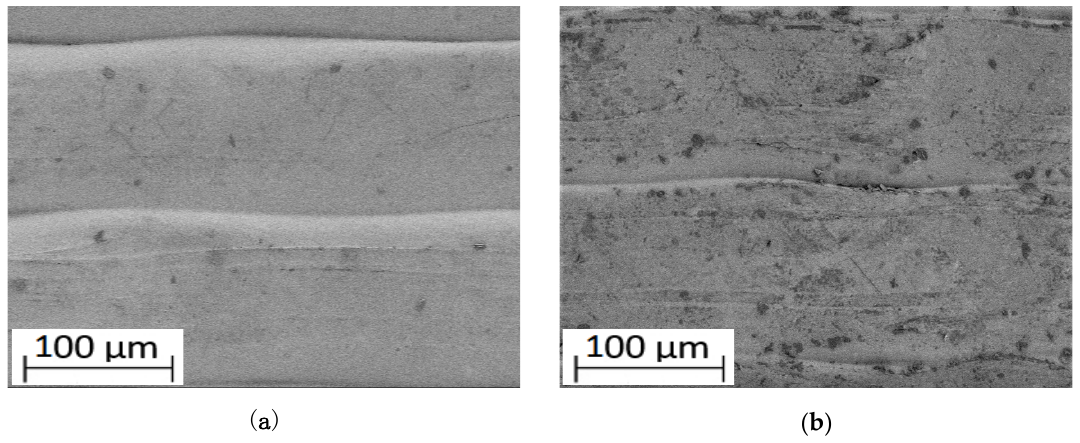
Figure 5. SEM images of the surface of ASA-coated ABS specimen ( a ) before and ( b ) after 1200 h of exposure to UV radiation and moisture.